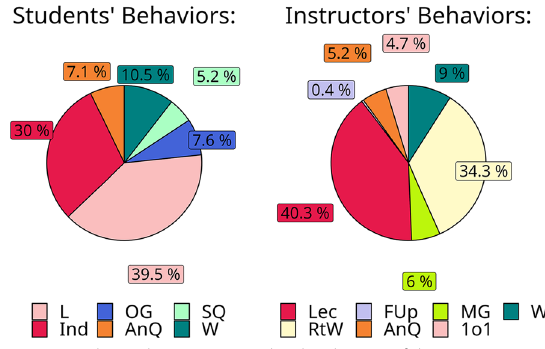
Fig. 2 Pie charts demonstrating the distribution of the COPUS behaviors over the observed theoretical classes